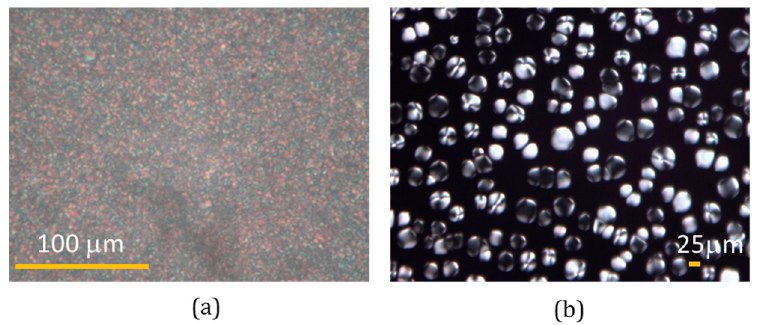
Figure 1. Images of PDLC films with ( a ) small and ( b ) large LC droplets observed under POM with crossed polarizers obtained after high- and low-intensity UV exposure with 12.3 and 0.96 mW/cm 2 for 10 min and 12 h, respectively.